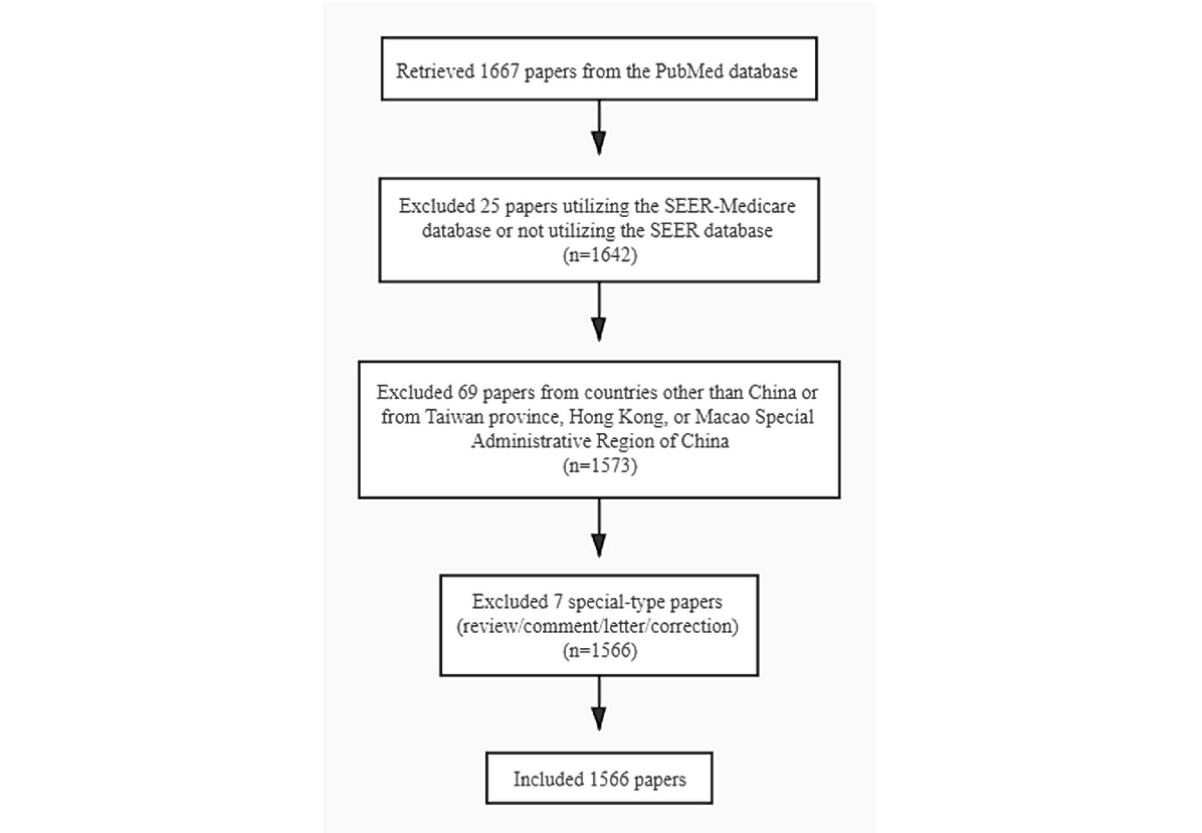
Figure 1. Flowchart of publication selection for the study.